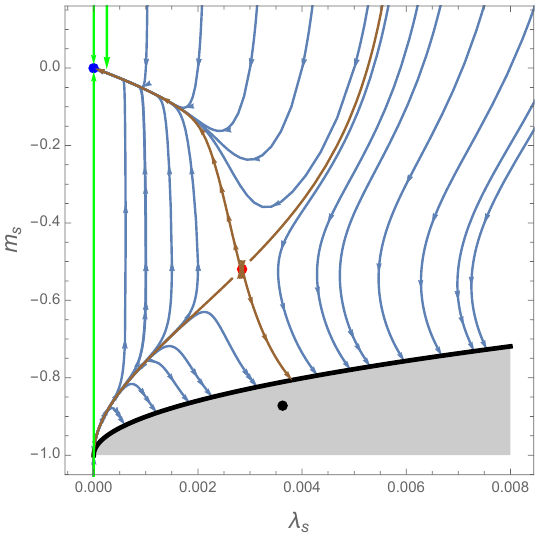
Figure 4. Renormalization group flow trajectories around the relevant fixed points obtained from a numerical integration. The Gaussian fixed point and the first non-Gaussian fixed point are respectively in blue and in red, and the last fixed point is in black. This fixed point is in the grey region bounded by the singularity line corresponding to the denominator of η . Finally, in green and brown, we draw the eigendirections around Gaussian and non-Gaussian fixed points, respectively. Note that that arrows of these fixed points are the flow oriented from IR to